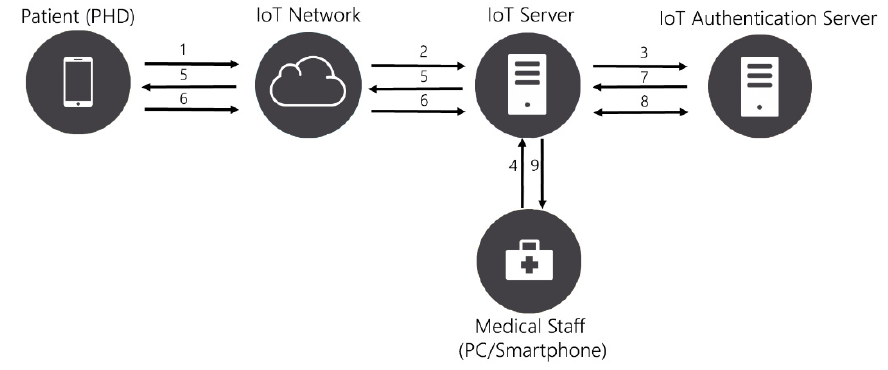
Figure 13. Buddy-ACK authorization scheme process